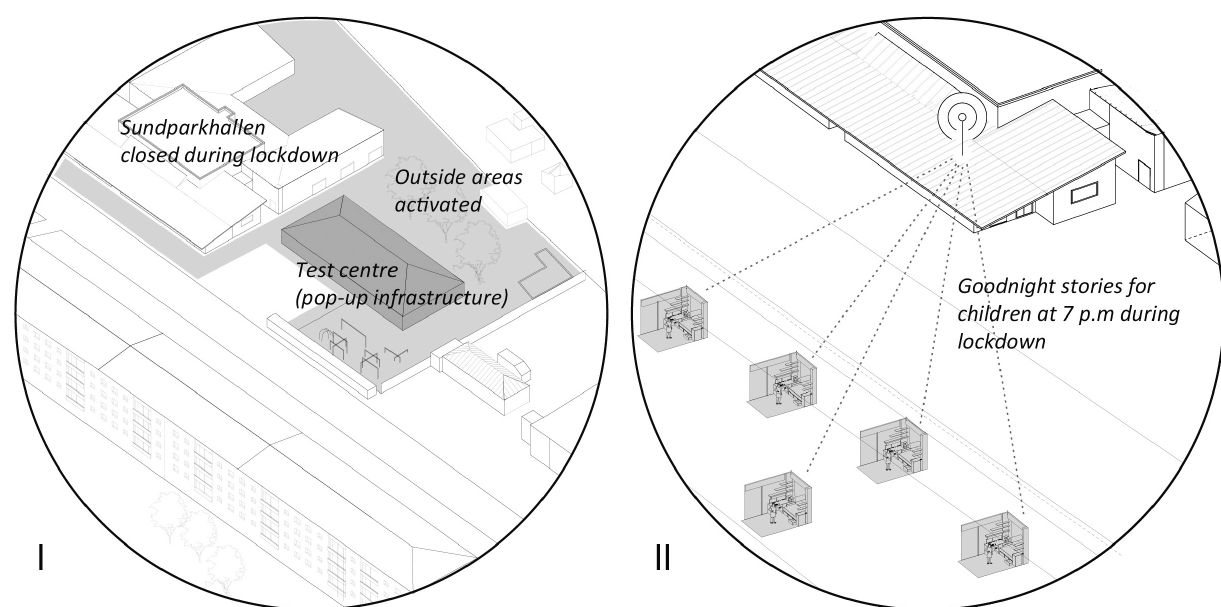
Figure 4. Informal shared spaces (I) and non‐physical platforms (II) in Sundparken.